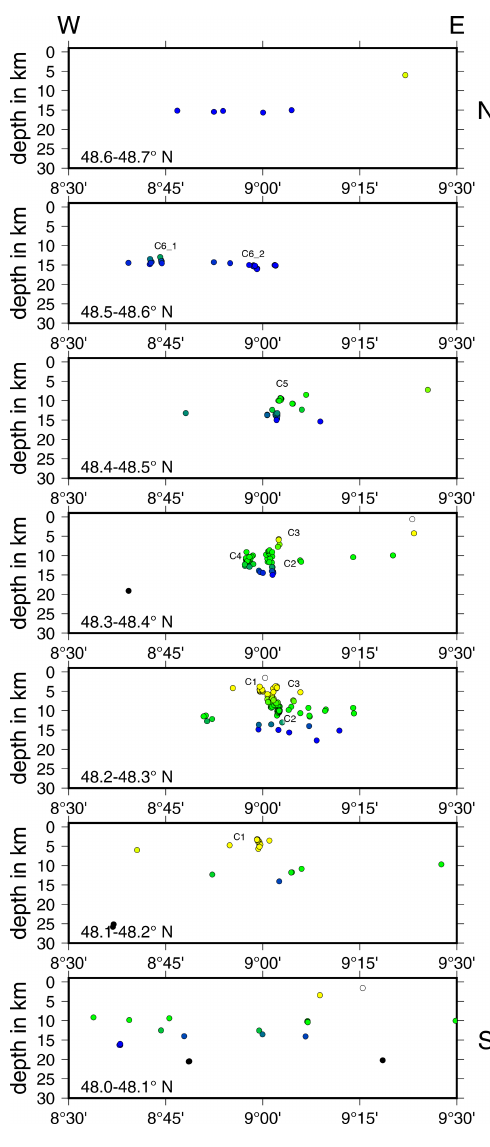
Figure 10. Seismicity distribution of the ASZ from north (top) to south (bottom). Circles indicate hypocenters in the corresponding slice, color-coded by depth (as in Fig. 7); cluster codes are given for